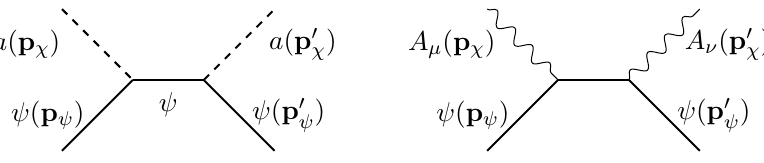
Figure 2 . Diagrams for the axial bosonic DM scattering with a fermion in the